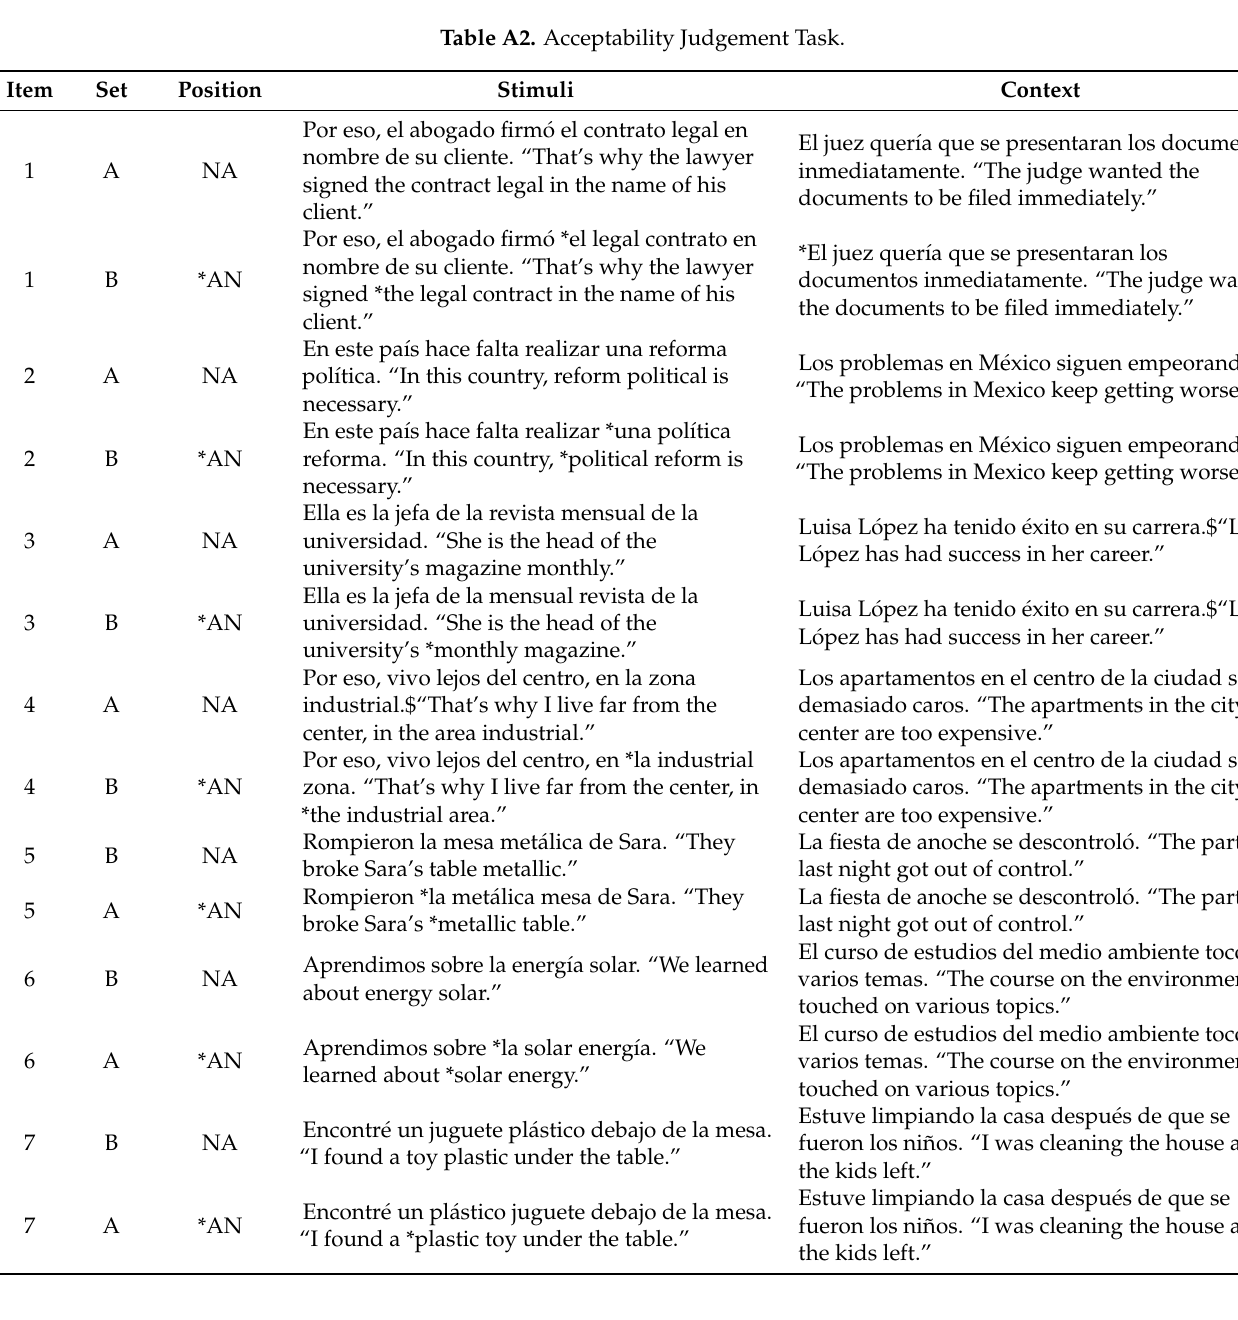
Table A2. Acceptability Judgement